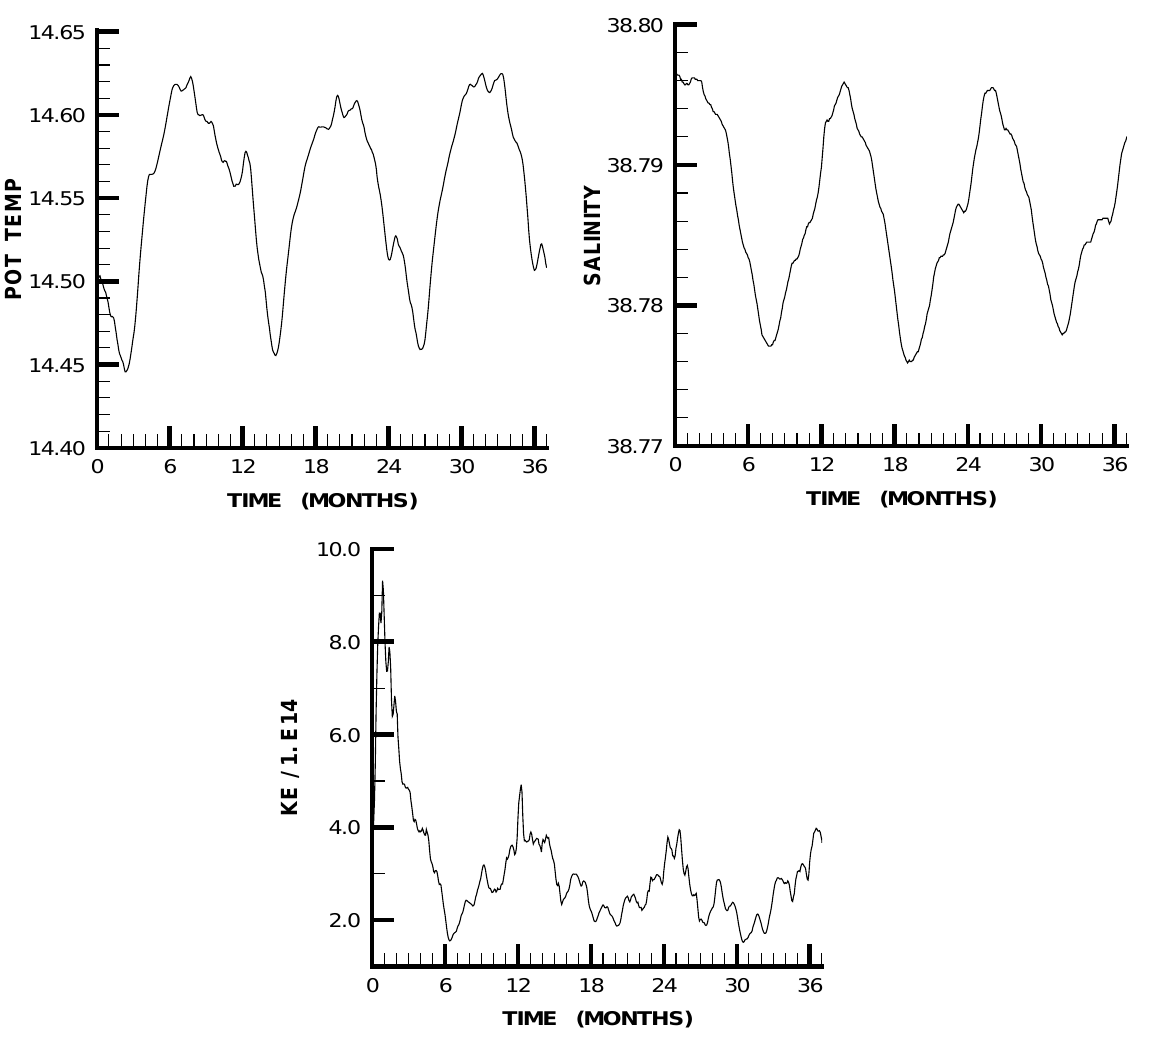
Fig. 2. Evolution of domain means of (a) potential temperature, (b) salinity, and (c) kinetic energy during the three years of integration.